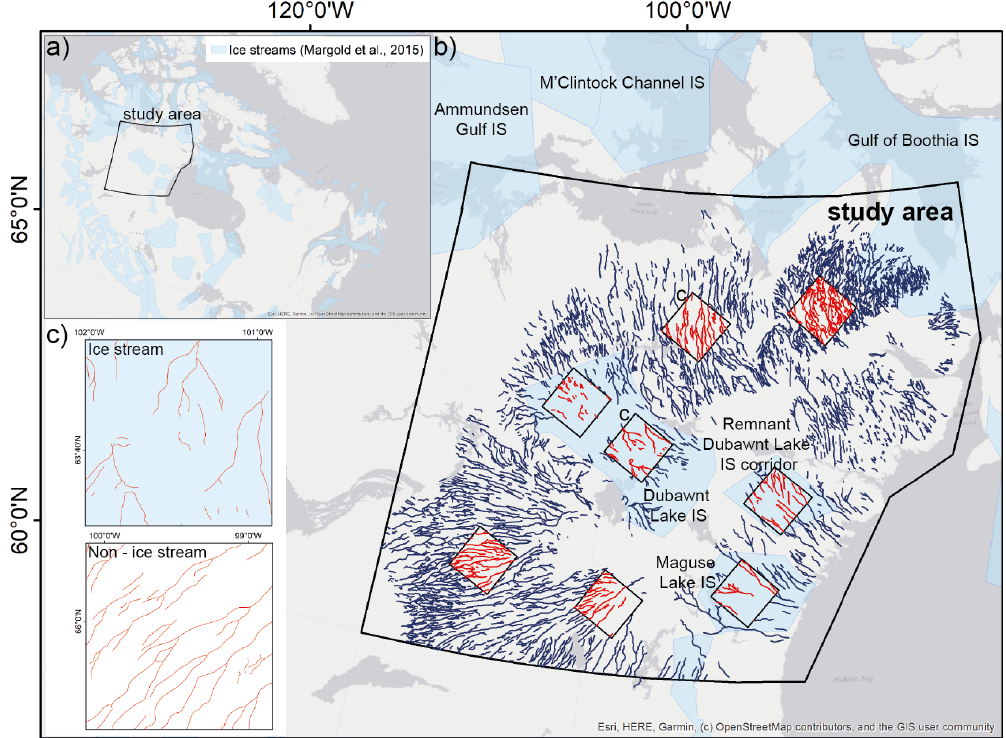
Figure 12. (a) Comparison of meltwater routes and palaeo-ice streams (Margold et al., 2015); (b) spatial density was calculated for each of the randomly placed sample boxes (100 × 100km). Ice stream density was compared to the non-ice stream density using a two-sample t test. The null hypothesis is rejected at the 5% significance level ( p = 0 . 03); (c) visual comparison between meltwater routes in ice stream and non-ice stream